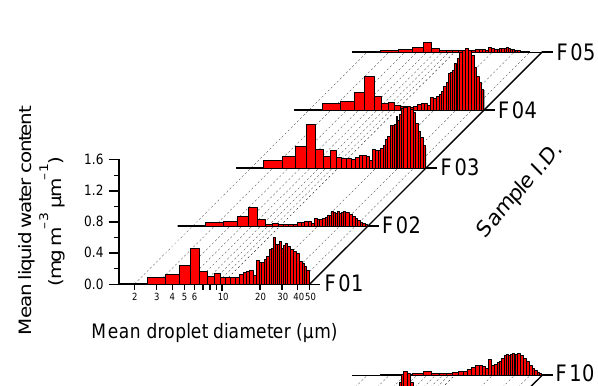
a TIN represents total inorganic nitrogen. In this study, total inorganic nitrogen is defined as including NH + NO − 3 ; i.e. TIN = NH + 4 +NO − 3 . b The mean dry, wet, and sea fog deposition fluxes for TIN and the contribution of each deposition to TIN input when the dry deposition fluxes for gaseous NH 3 (2.0µmolm − 2 d − 1 ) and HNO 3 (4.7µmolm − 2 d − 1 ) reported by Zhang et al. (2010) are included.